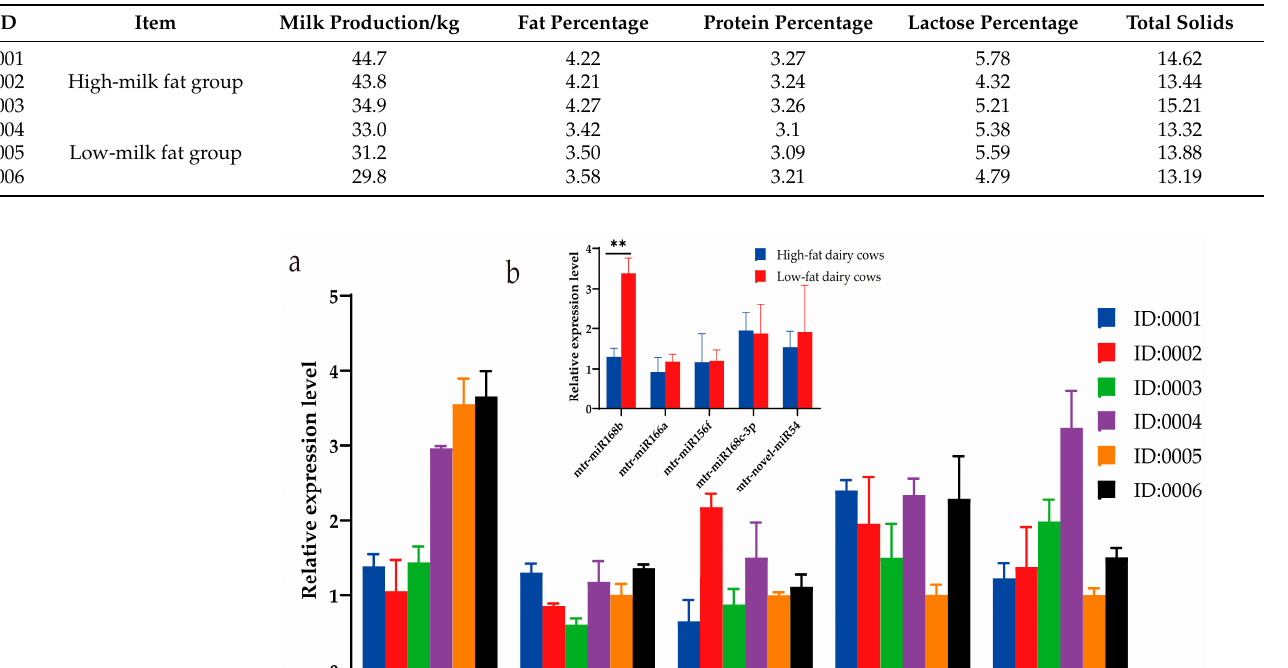
Figure 3. Relative expression of alfalfa miRNAs in milk as determined using qRT-PCR. Data are given as the mean ± SD for n = 3/group. * p < 0.05 was considered statistically significant. ( a ) miRNA expression levels in milk and ( b ) significant difference in miRNAs between high-fat-milk and low- fat-milk dairy cows.